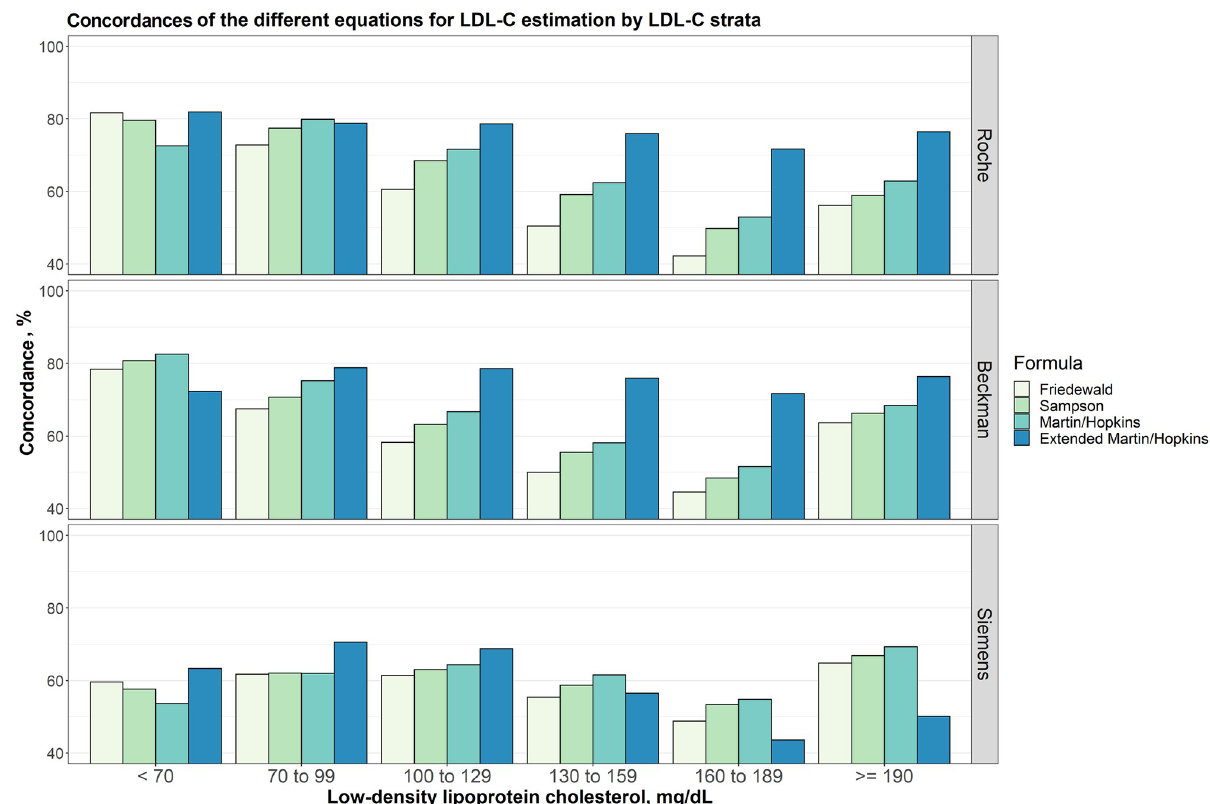
Fig 3. Concordances of the different equations for LDL-C estimation by LDL-C strata. Concordances of different equations for LDL-C estimation by LDL-C groups assuming different direct measures (i.e., Roche, Beckman and Siemens) are given in a clustered bar chart. Each bar indicates the concordance of estimating LDL-C levels by different formulas for each group of LDL-C levels given that the LDL-C levels measured by Roche, Beckman and Siemens direct methods, accordingly.